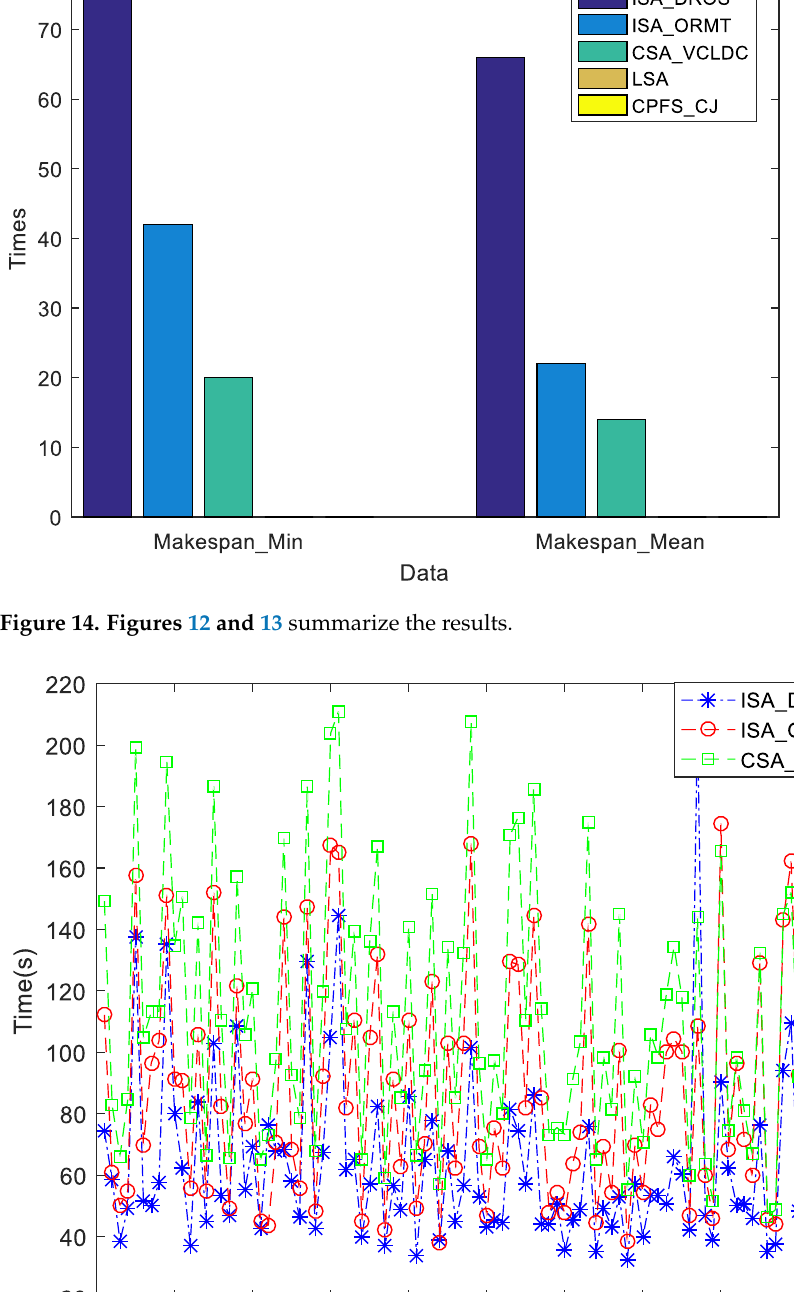
Figure 13. The average time required by each of the five algorithms to process products.